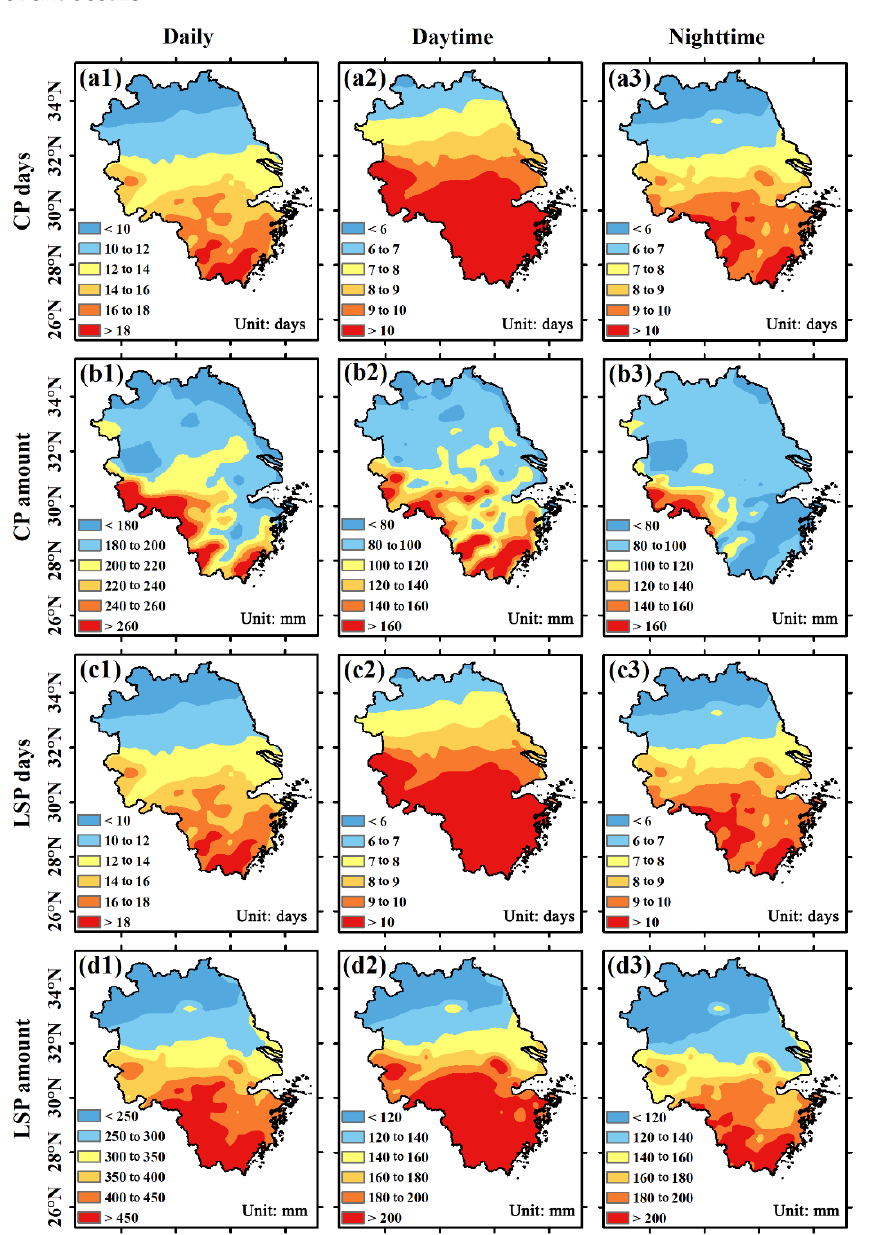
Figure 9. Annual mean convective/large-scale precipitation days ( a1 – a3, c1 – c3 ) and amounts ( b1 – b3, d1 – d3 ) contributing to extreme precipitation at the daily, daytime, and nighttime scales.